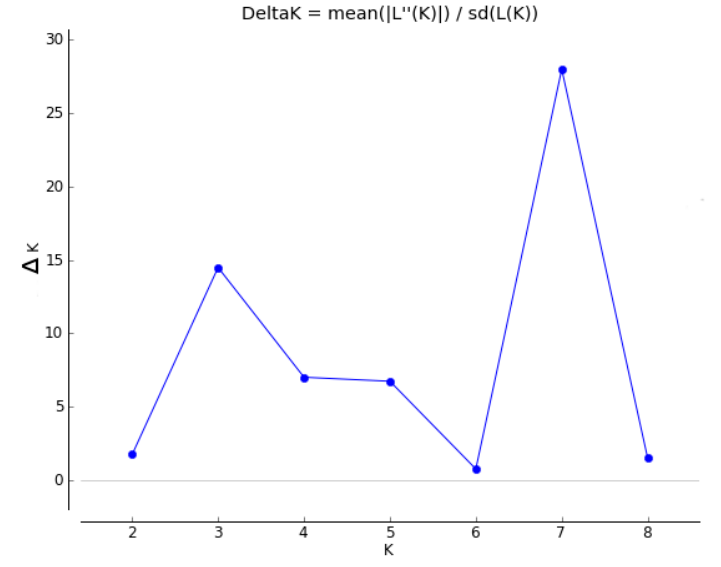
Figure 1. Δ K output from Structure Harvester.